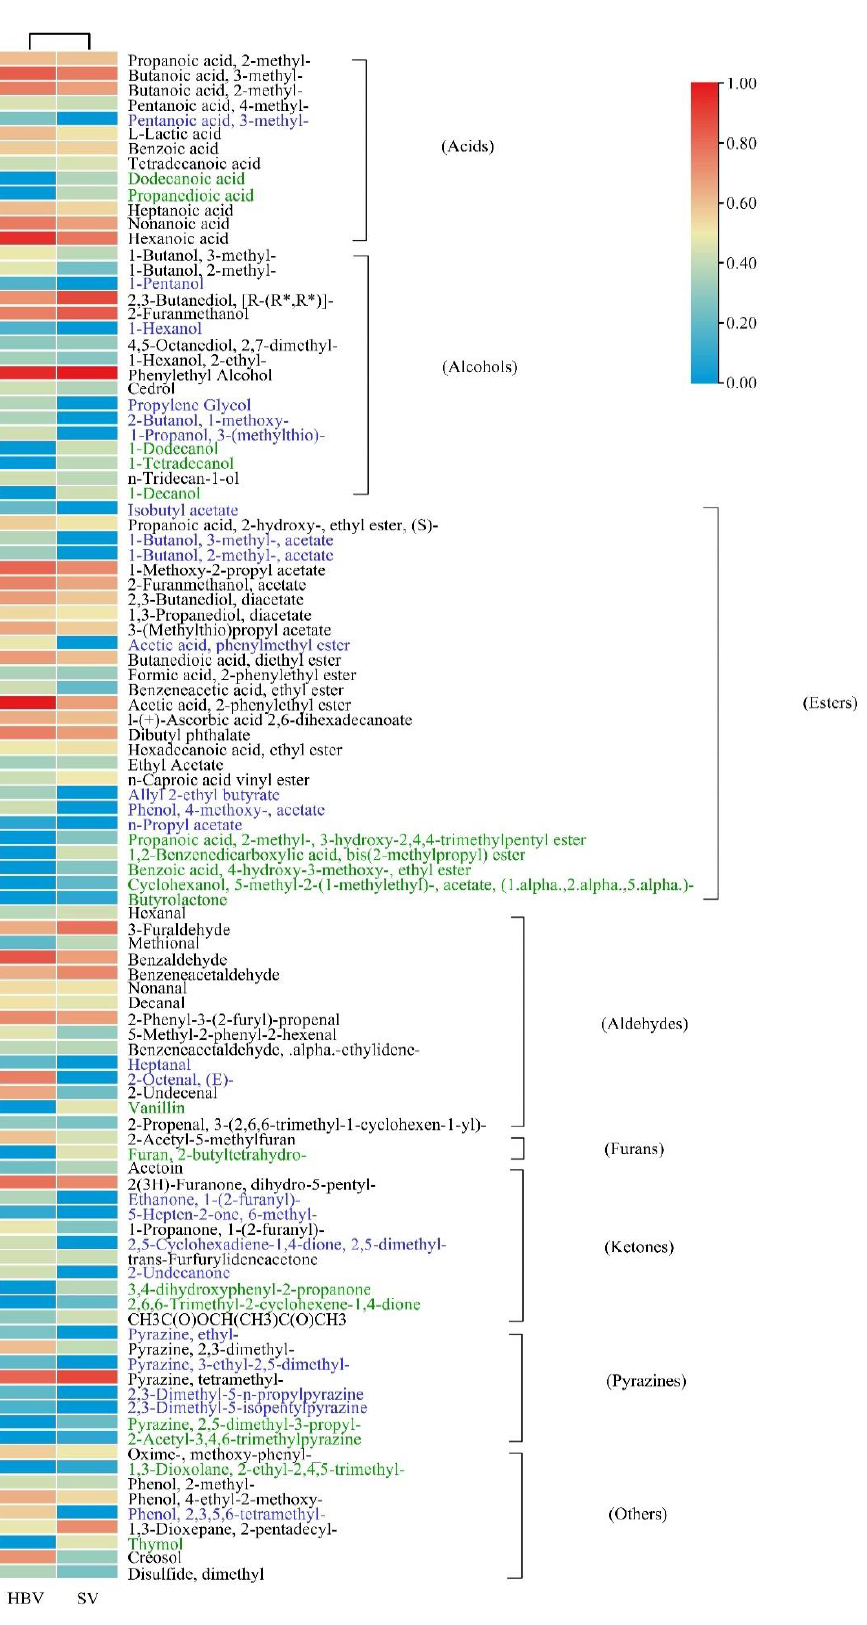
Figure 4. Heatmap of VFCs from aged HBV and SV. The black fonts indicate the common VFCs, while the blue and green fonts indicate the unique VFCs in both of aged HBV and SV, respec- tively.